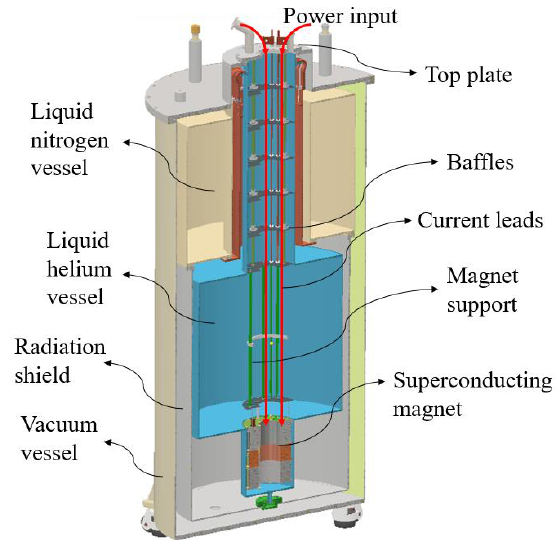
Figure 1. Drawing of the 5 T superconducting magnet for the Electromagnetic Property Measurement System (EMPS) . Table 1. Specifications of the low temperature superconducting magnet.